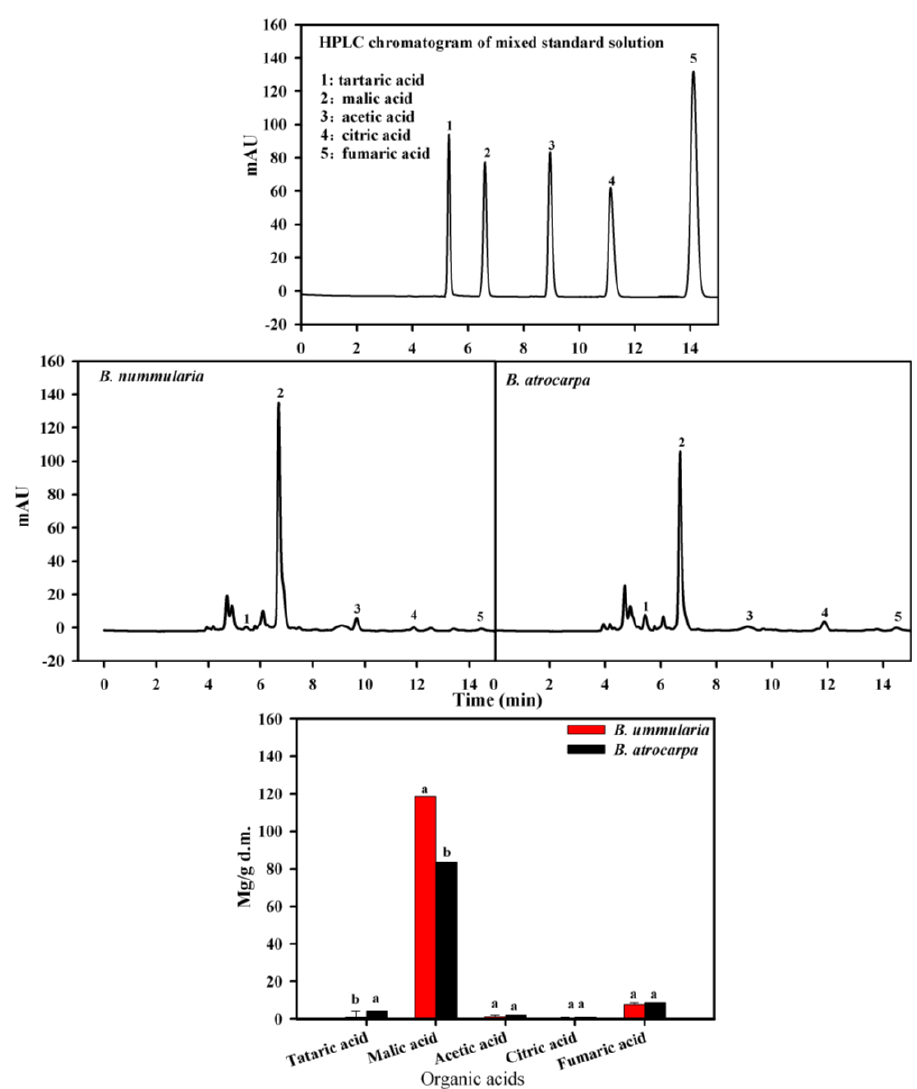
Figure 2. HPLC chromatogram of mixed standard solution and organic acid content in the fruits of B. nummularia and B. atrocarpa. Mean ± SD indicate three replicates. Different letters indicate significant difference ( p < 0.05).